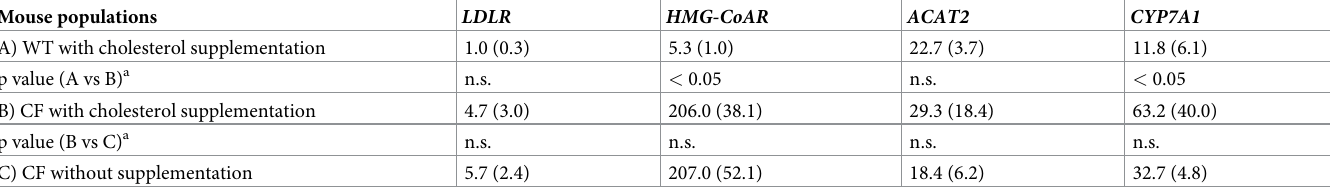
Table 6. Liver mRNA expression in supplemented CF mice in comparison to supplemented WT and no supplemented CF mice.